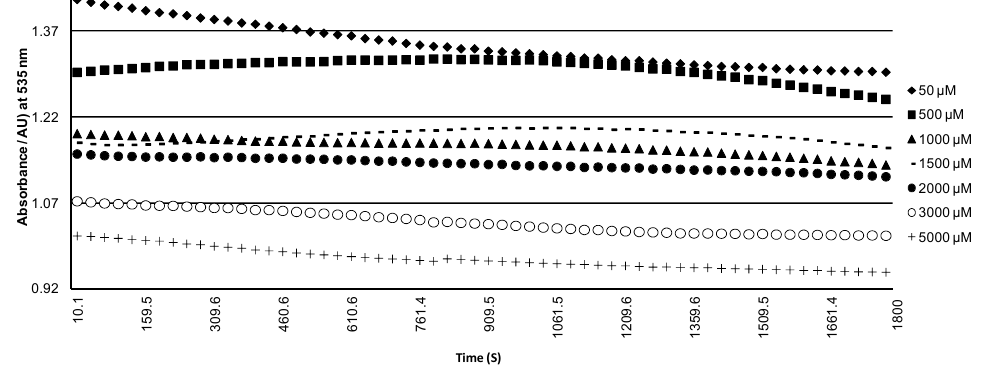
Figure 2. Betacyanins bleaching kinetics at different CuSO 4 concentrations in purple cactus pear juices treated by ultrasound.